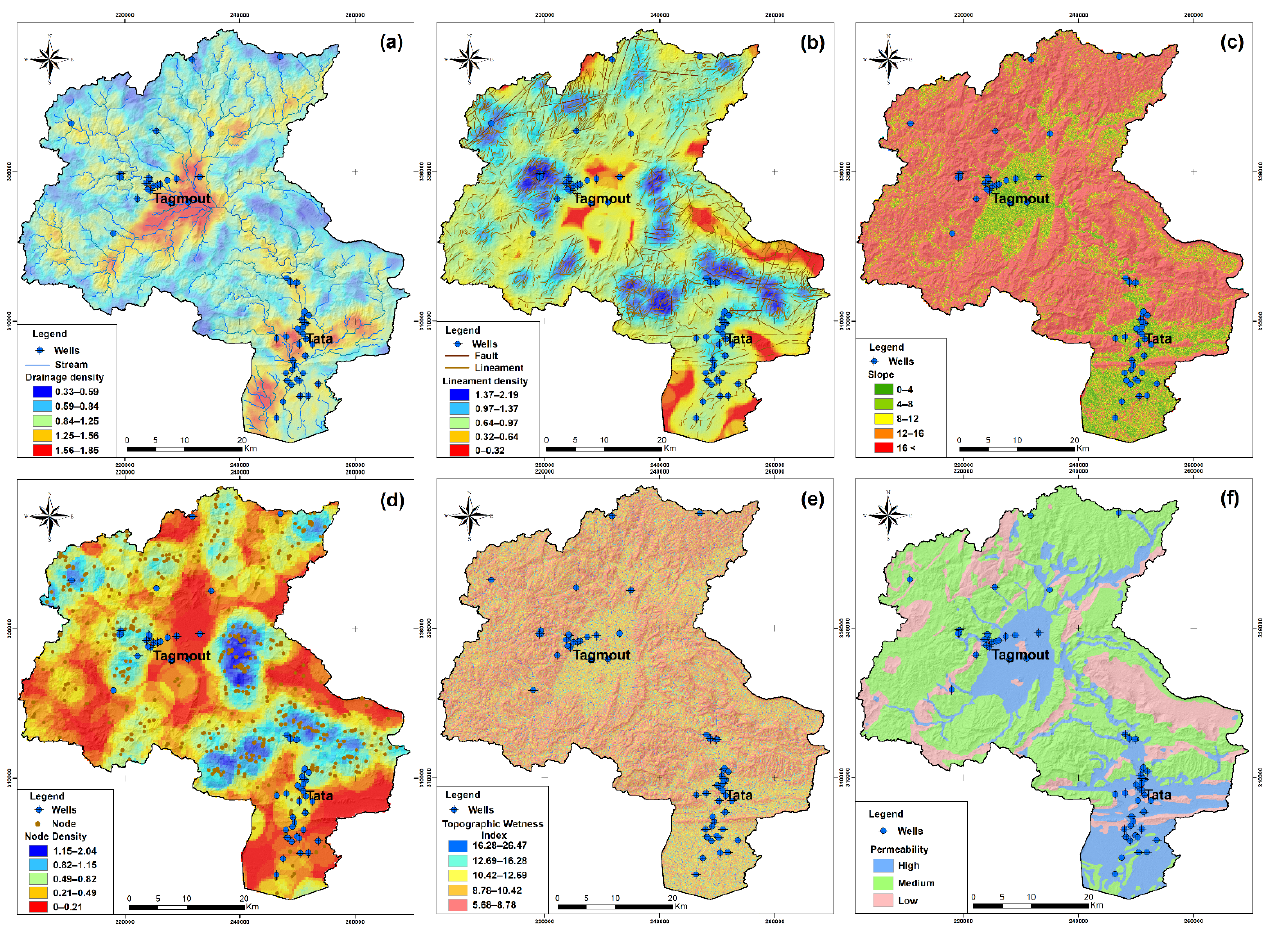
Figure 5. Variation maps of the factor influencing the groundwater potential map (part 1): ( a ) drainage density (DD); ( b ) lineament density (LD); ( c ) slope (SL); ( d ) node density (ND); ( e ) topographic wetness index (TWI); and ( f ) permeability (PER).